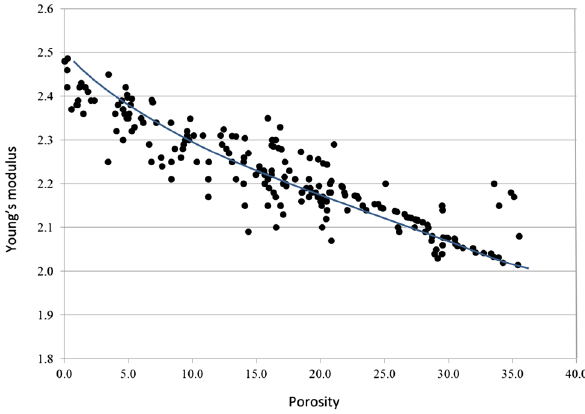
Fig. 10 Plot showing correlation of Young’s modulus and porosity for K -level 23 of 3D reservoir